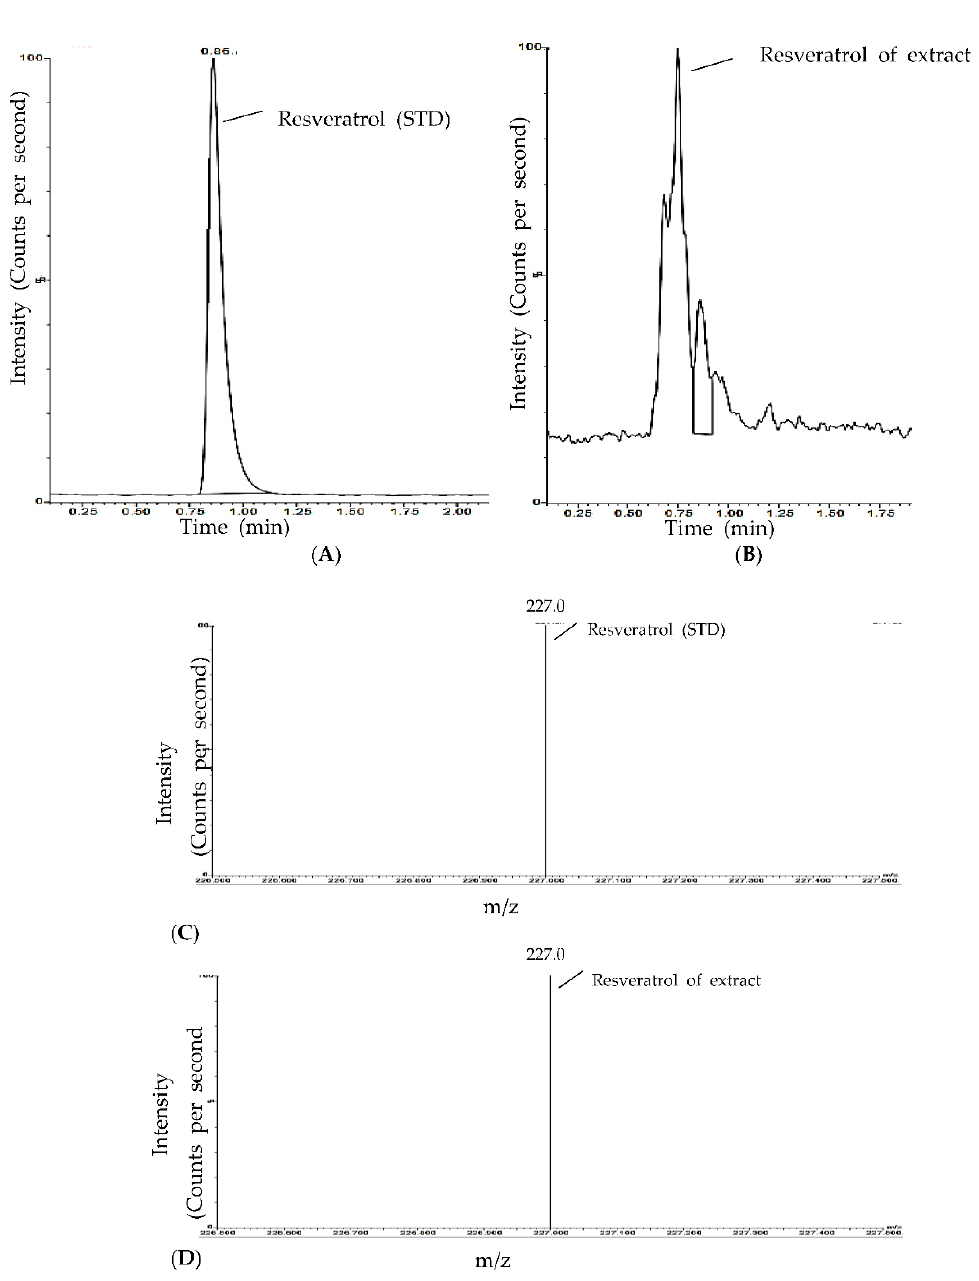
FL: fluorescent light, RL: red LED, BL: blue LED, GL: green LED, MEL: micro-electrodeless light, UL: ultrasound+ FL. Mean values within a column with the same lowercase letters were not sig- nificantly different ( p < 0.05), according to Duncan’s multiple comparison test. 1 LOQ: limit of quantification .